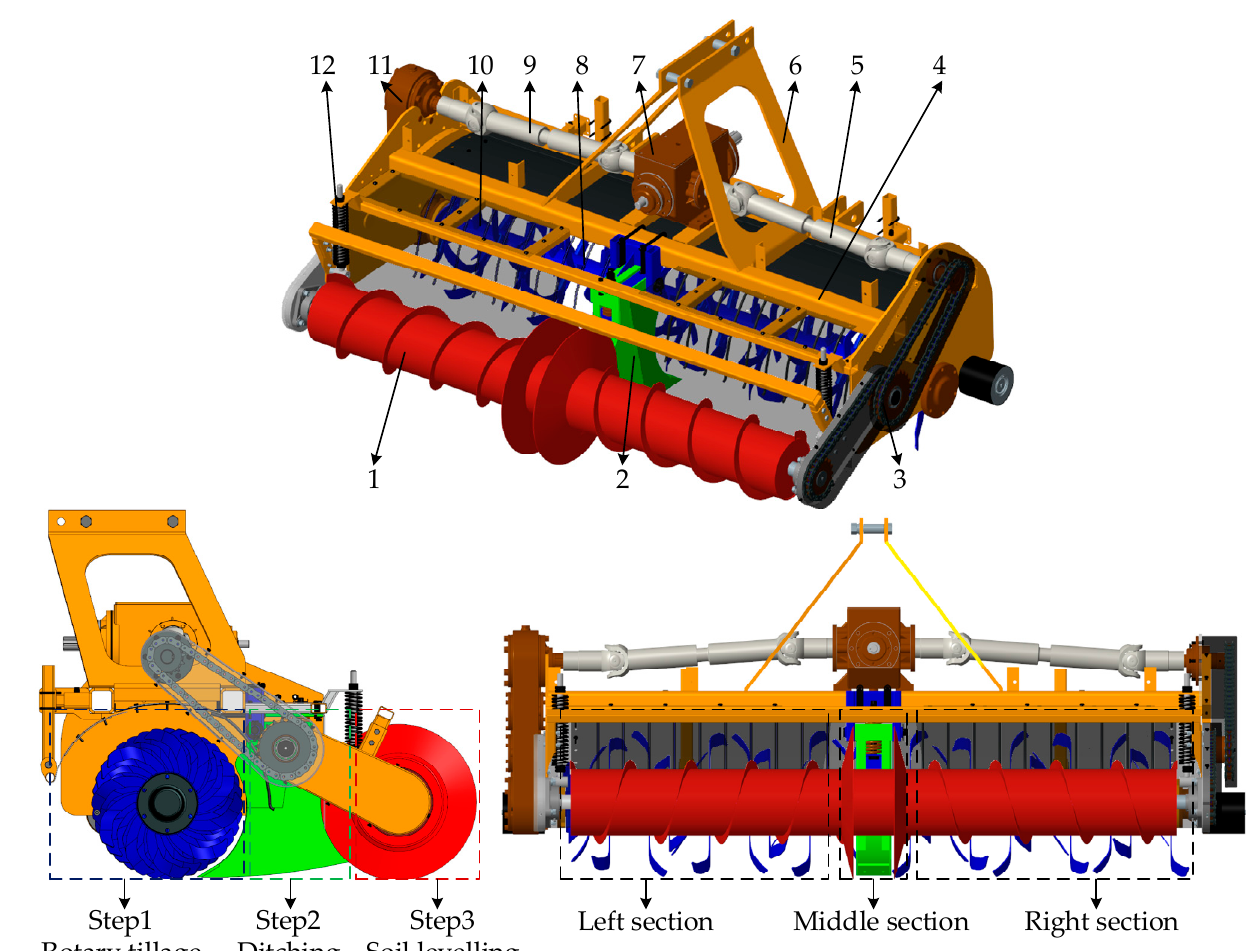
Figure 1. Structure diagrams of seedbed preparation machine of rapeseed combined transplanter.